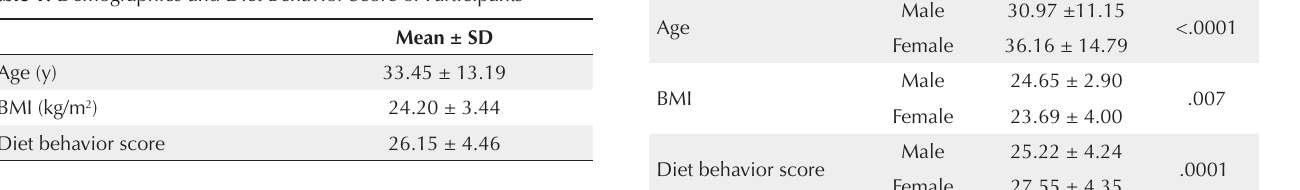
Table 1. Demographics and Diet Behavior Score of Participants